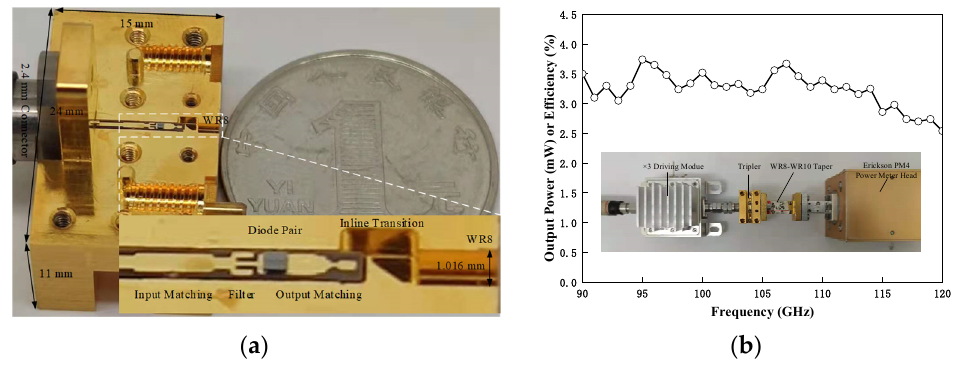
Figure 13. ( a ) The physical processing block and ( b ) measured conversion efficiency of 110 GHz frequency tripler with input power of 100 mW [75].